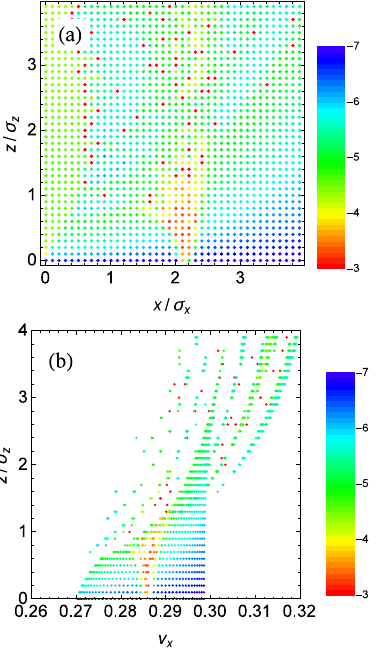
FIG. 10. Diffusion index for the crossing-angle collision with horizontal crossing only, and zero vertical amplitude ( y ¼ 0 ). The x and z amplitudes are scanned from 0 to 4 σ with a 0 . 1 σ step.